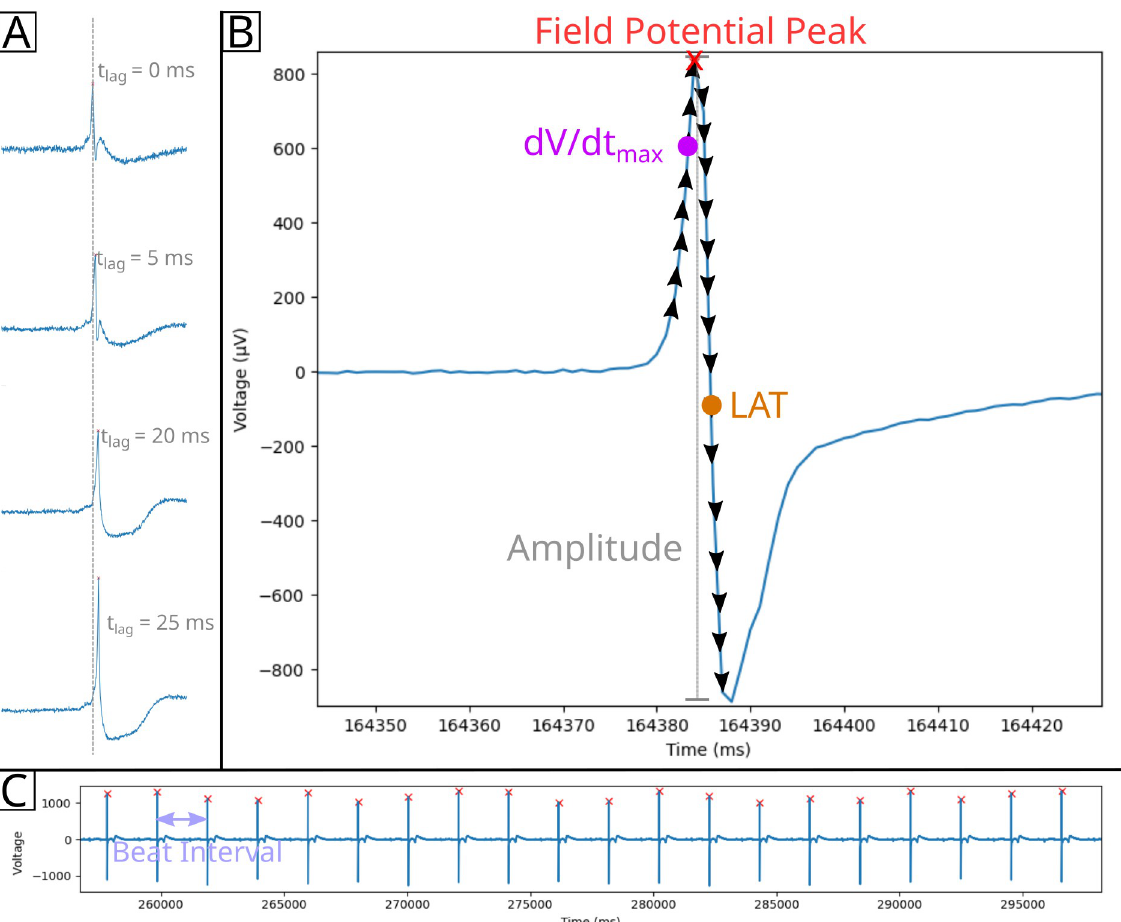
Fig 5. Diagram of cardiomyocyte field potential property calculations. A) Time lag (t lag , pacemaker) calculation. The field potential peak for each electrode is calculated, then the peak with the minimum time is normalized to 0 ms. This process is applied to all electrodes to yield normalized time lag values for the given beat. B) Amplitude (gray vertical line), dV/dt max , and LAT can be calculated from the field potential signal. Black arrows indicate derivative calculations along points prior to or after the field potential peak (red x). The maximum positive (dV/ dt max , magenta circle) and negative (LAT, orange circle) derivatives are identified and used in calculating dV/dt max and LAT, respectively. C) Beat intervals are calculated by determining the time between field potential peaks. To access this operation, select ‘Calculations’ ! ‘Upstroke Velocity’ from the main window menu bar. A new window will open that displays a heat map for the dV/dt data of each elec- max trode for the specified beat. The legend to the right describes the color coding: dark blue corre- sponds to the observed minimum, while dark red corresponds to the observed maximum. The slider along the bottom enables users to toggle between data for each individual beat. Beat amplitude and beat interval calculations. Beat amplitude refers to the voltage mag- nitude of the primary peak (R-wave-like peak) of the field potential for a detected beat. Because these potentials encompass both positive and negative peaks, the beat amplitude calculation in Cardio PyMEA identifies both the positive and negative field potential signals at the location of the R-wave-like peak when determining the overall magnitude of the beat [19]. This is indi- cated in Fig 5B. The beat interval is calculated by identifying the time that Beat A occurred and subtracting that value from the time that Beat B occurred. This difference reflects the interval between the beats and is shown in Fig 5C. Beat intervals are calculated this way for all beats in